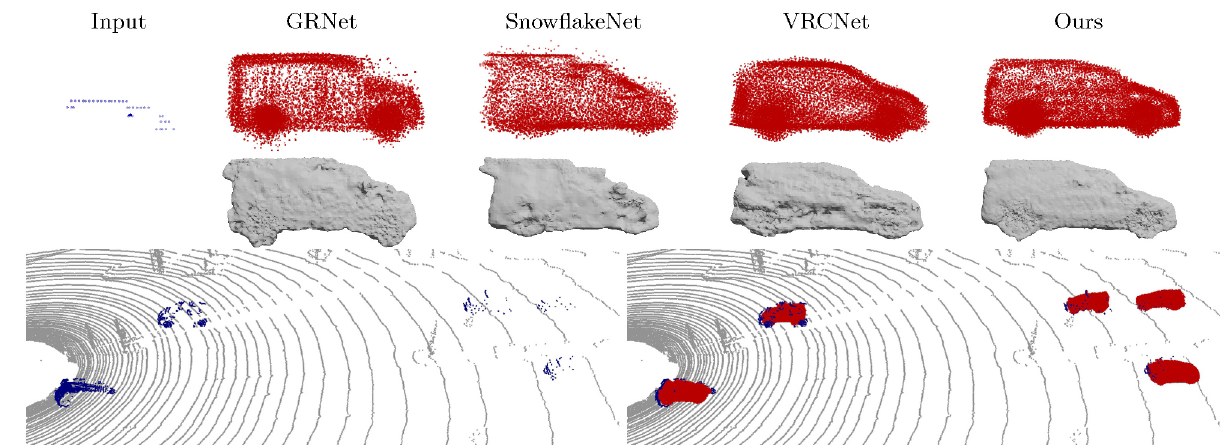
Fig. 7 Qualitative point cloud completion and surface reconstruction results on the KITTI dataset.